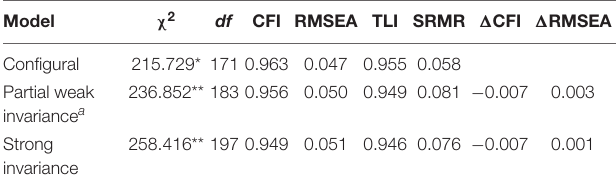
TABLE 2 | Measurement invariance over time in study 1.